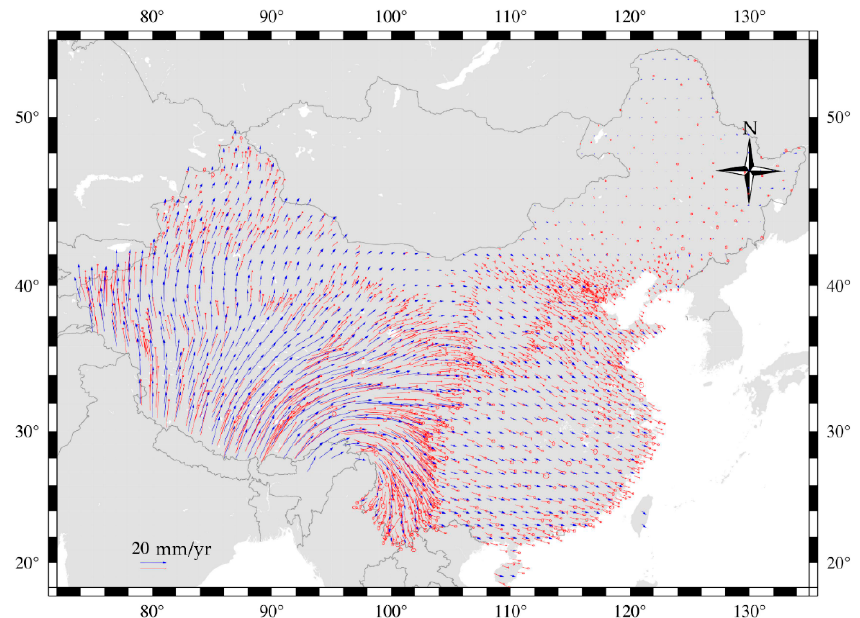
Figure 2. Interpolating horizontal velocity field in continental China (the red lines represent original velocity field data, and the blue lines represent interpolating velocity field data).